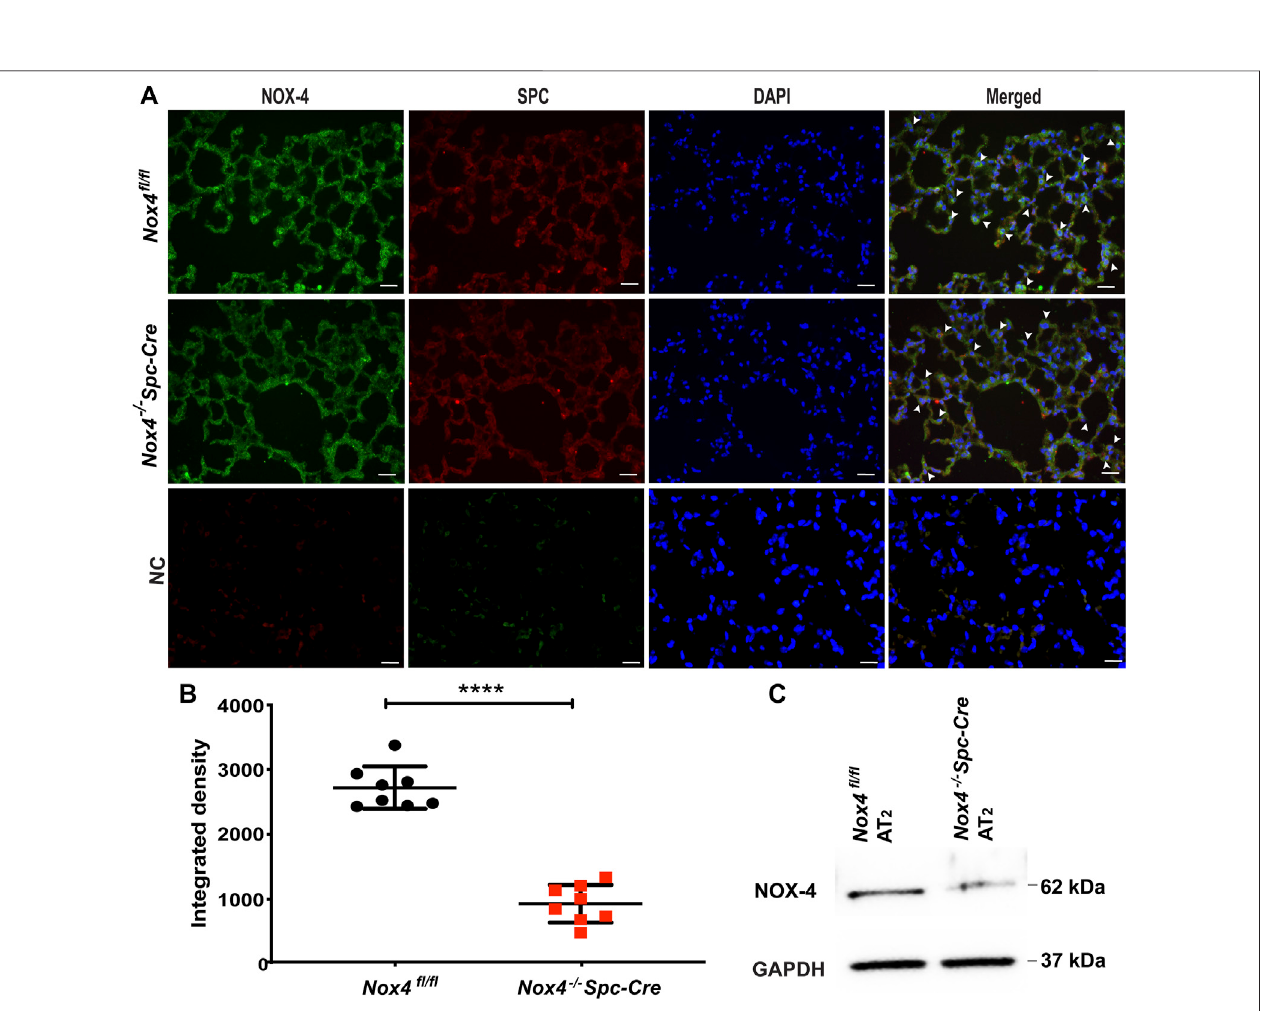
FIGURE 2 | NOX4 expression is downregulated in the lungs and isolated AT2 cells from Nox4 − / − Spc-Cre mice. Nox +/- Spc-Cre animals were injected with tamoxifen to generate Nox4 − / − Spc-Cre animals and IHC was performed on the harvested lungs. (A) Representative immuno fl uorescent micrographs of lung tissue showing individual staining as well as co-staining of NOX4 and AT2 pneumocyte marker SPC (merge of green and red). Co-localization of NOX4 (green) and SPC (red) could be seen in lungs of Nox4 fl / fl mice, but not in Nox4 − / − Spc-Cre mice as indicated with white arrows (B) Quanti fi ed data of NOX4 fl uorescence intensity from NOX4-SPC co-stained lung tissue (C) Expression of NOX4 in primary AT2 cells isolated from Nox4 fl / fl and Nox4 − / − Spc-Cre mice lung. n = 3 **** p < 0.0001.